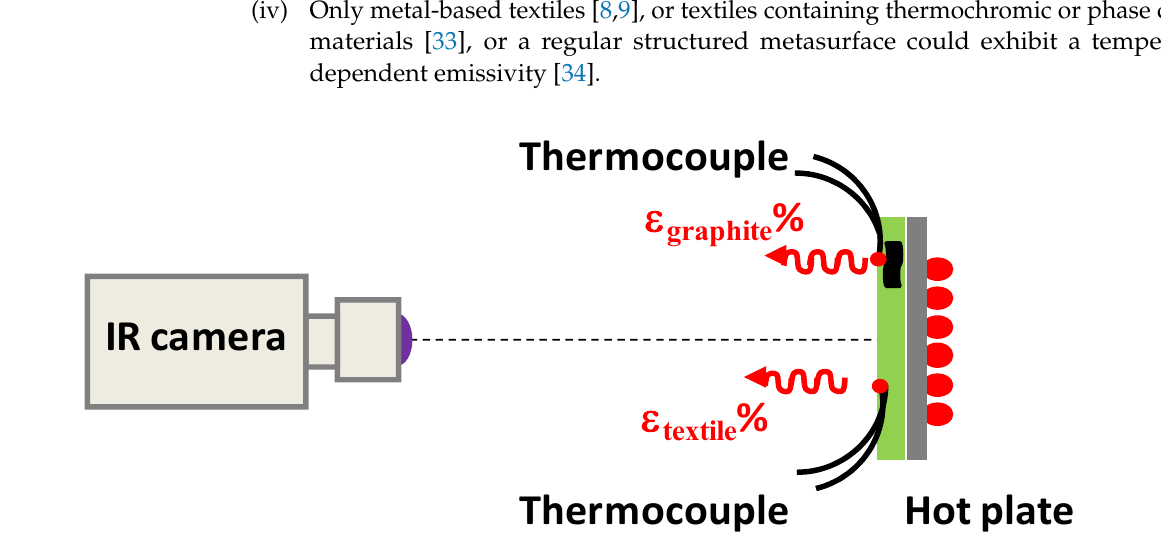
Figure 5. Sketch of the experimental setup employed for the characterization of the temperature- dependent bioceramic fabrics emissivity.